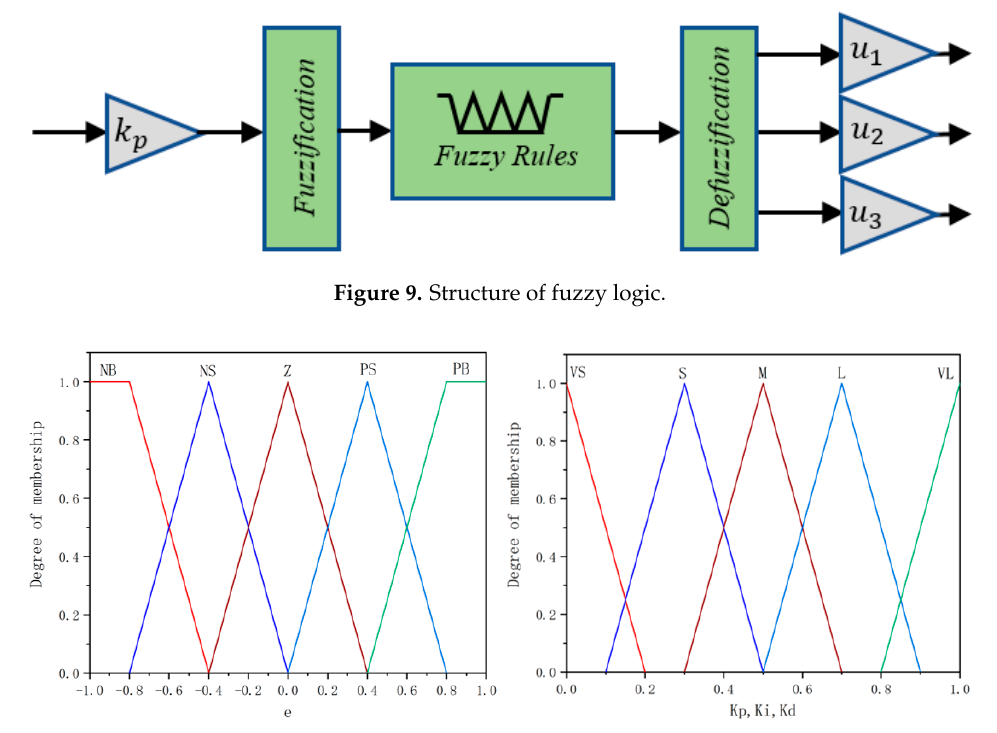
Figure 10. Membership functions. Table 1. Fuzzy rules for fuzzy PID.